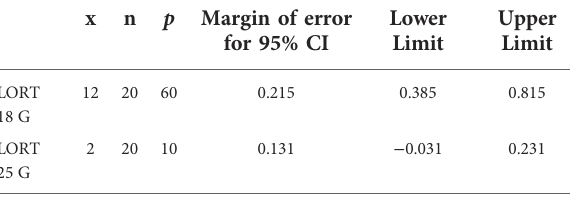
TABLE 3 The z -test for independent proportions for the difference in the epidural space detection by LORT between 18 G and 25 G groups.